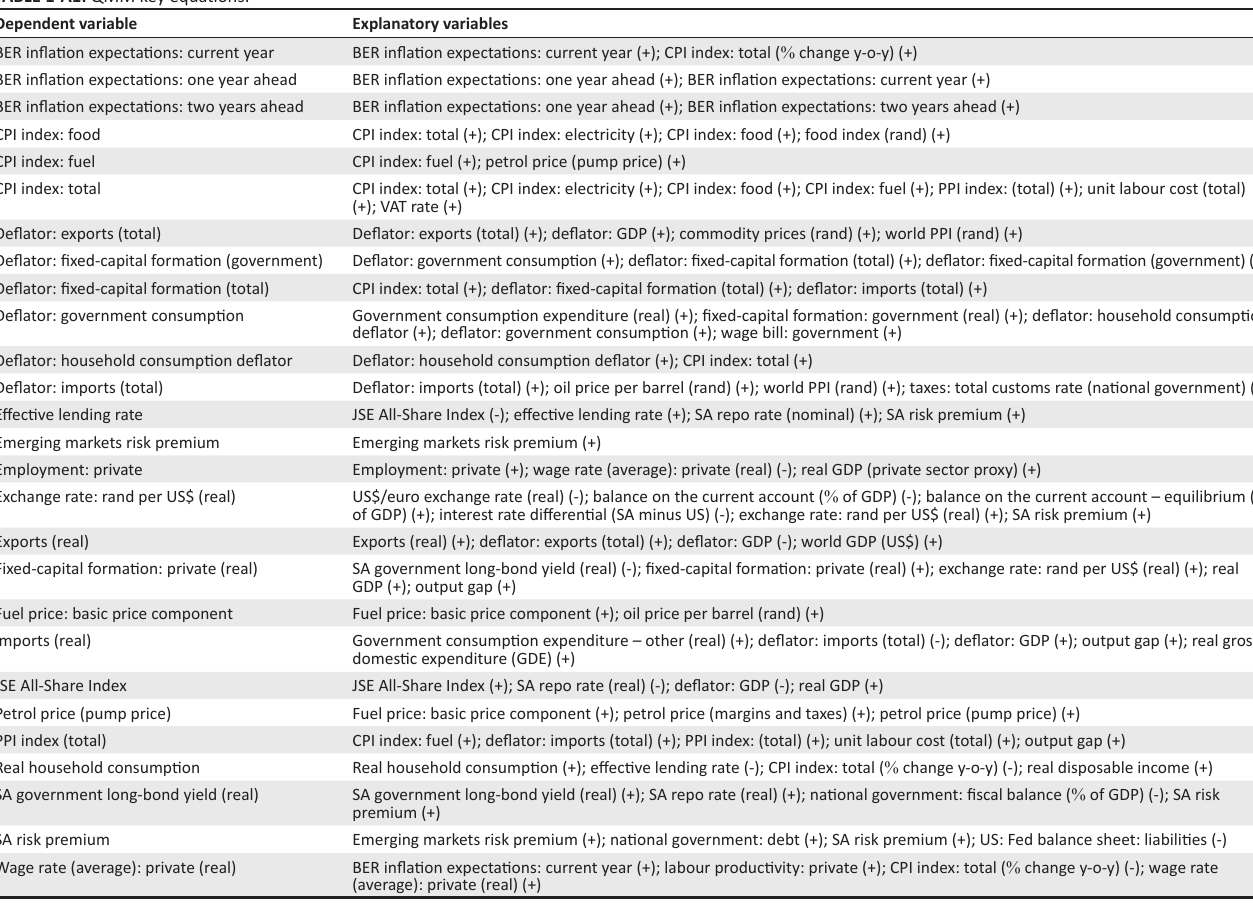
TABLE 1-A1: QMM key